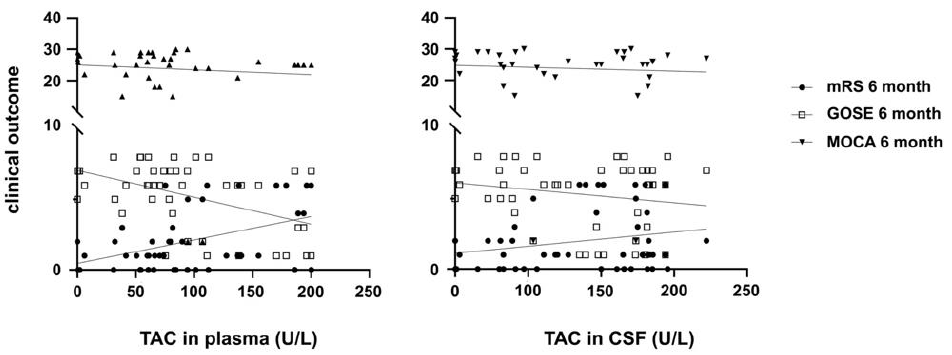
Figure 3. Correlation of TAC with clinical outcome. Increased plasma TAC correlated with a worse neurological outcome measured by modified Rankin Scale (mRS), Glasgow Outcome Scale Extended (GOSE) and MoCA after 6 weeks and 6 months ( p = 0.011; p = 0.0007).